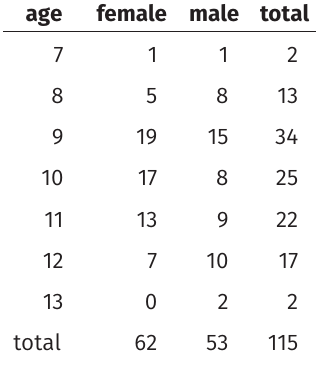
Table 11: Age and gender distribution of children